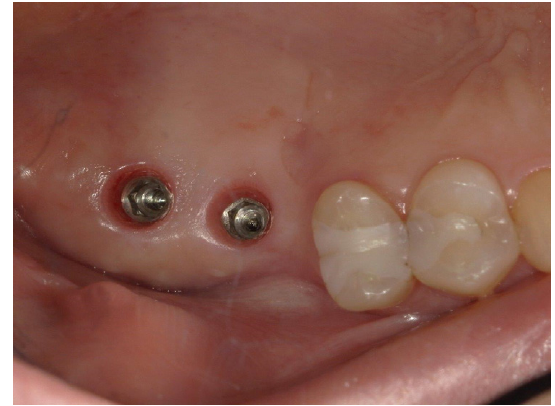
Figure 8. Good healing of soft tissues.